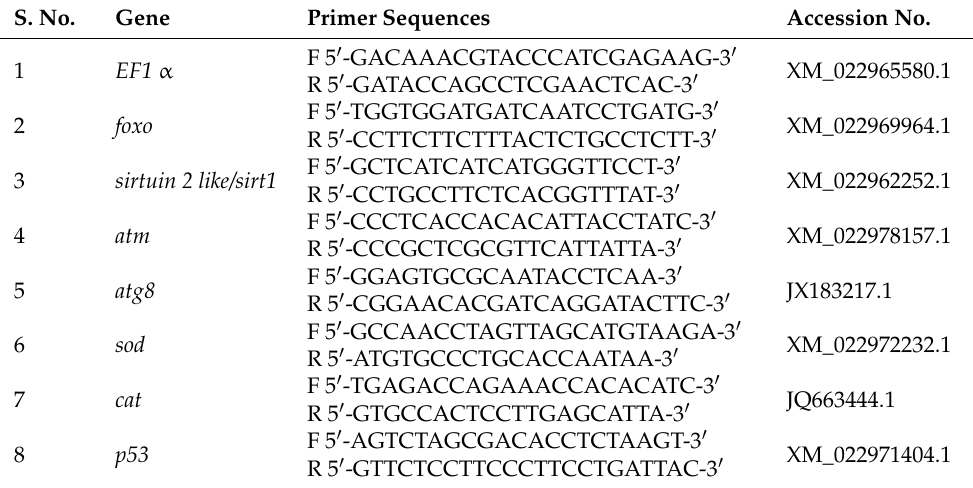
Table 1. Details of primer sequences used for the quantitative real-time PCR (qPCR). S.